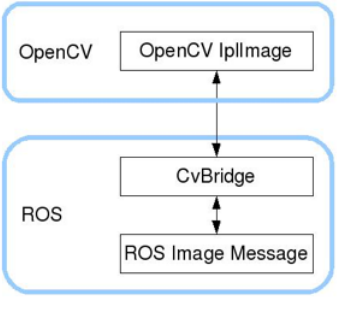
Figure 3. CvBridge